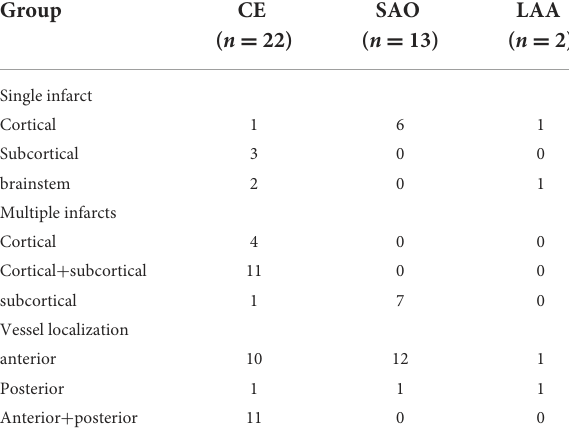
TABLE 3 Brain MRI features of hypertrophic cardiomyopathy with ischemic stroke ( n = 37). Group